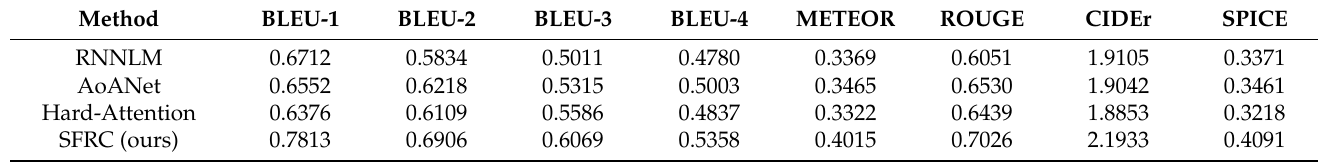
Table 8. Comparison of evaluation metric scores of methods on 60% Sydney-Captions